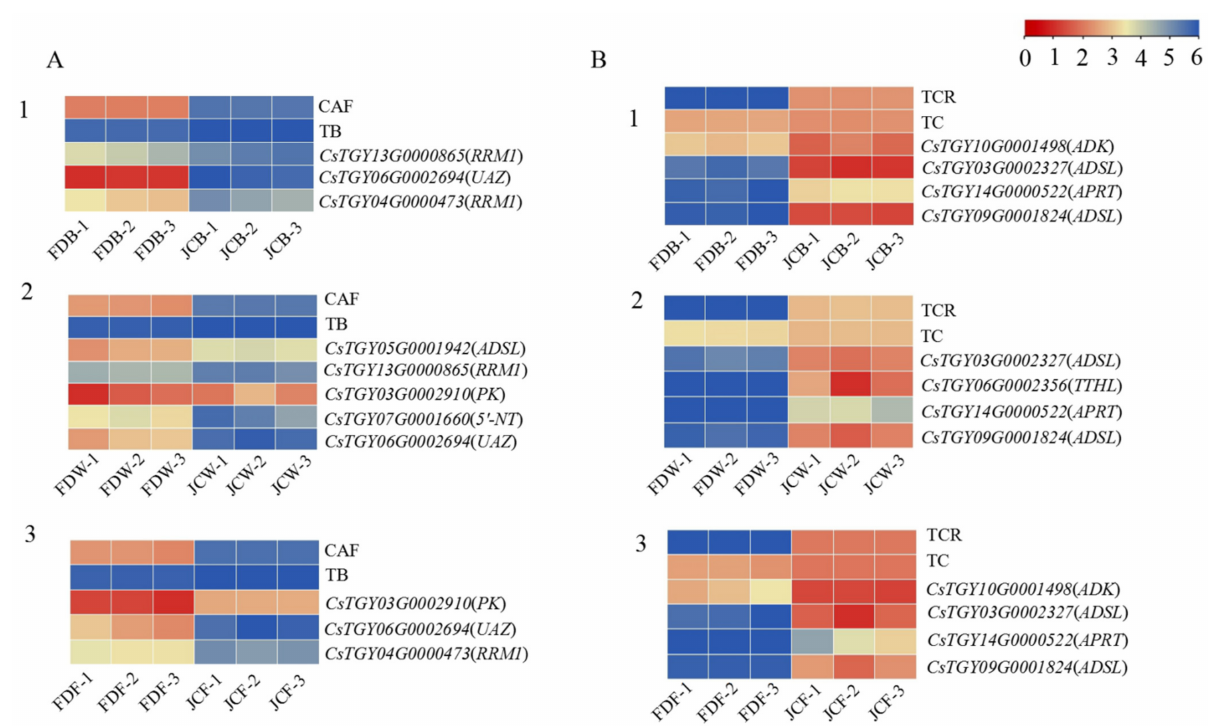
Figure 9. Heatmap of DEGs of purine alkaloid pathway in green module and the content of CAF and TB ( A ). Heatmap of DEGs of purine alkaloid pathway in brown module and the content of TCR and TC ( B ). 1. DEGs in flower bud stage; 2. DEGs in whitening stage; 3. DEGs in full opening stage.